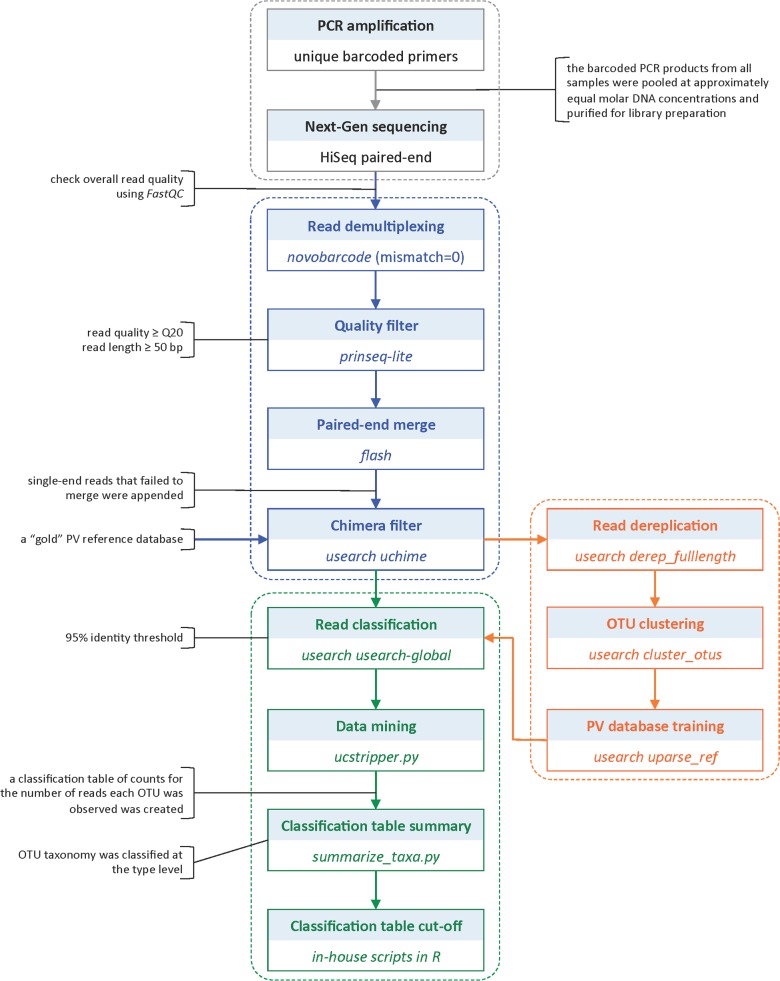
Detailed workflow of bioinformatics pipeline and taxonomic classification of HPV.